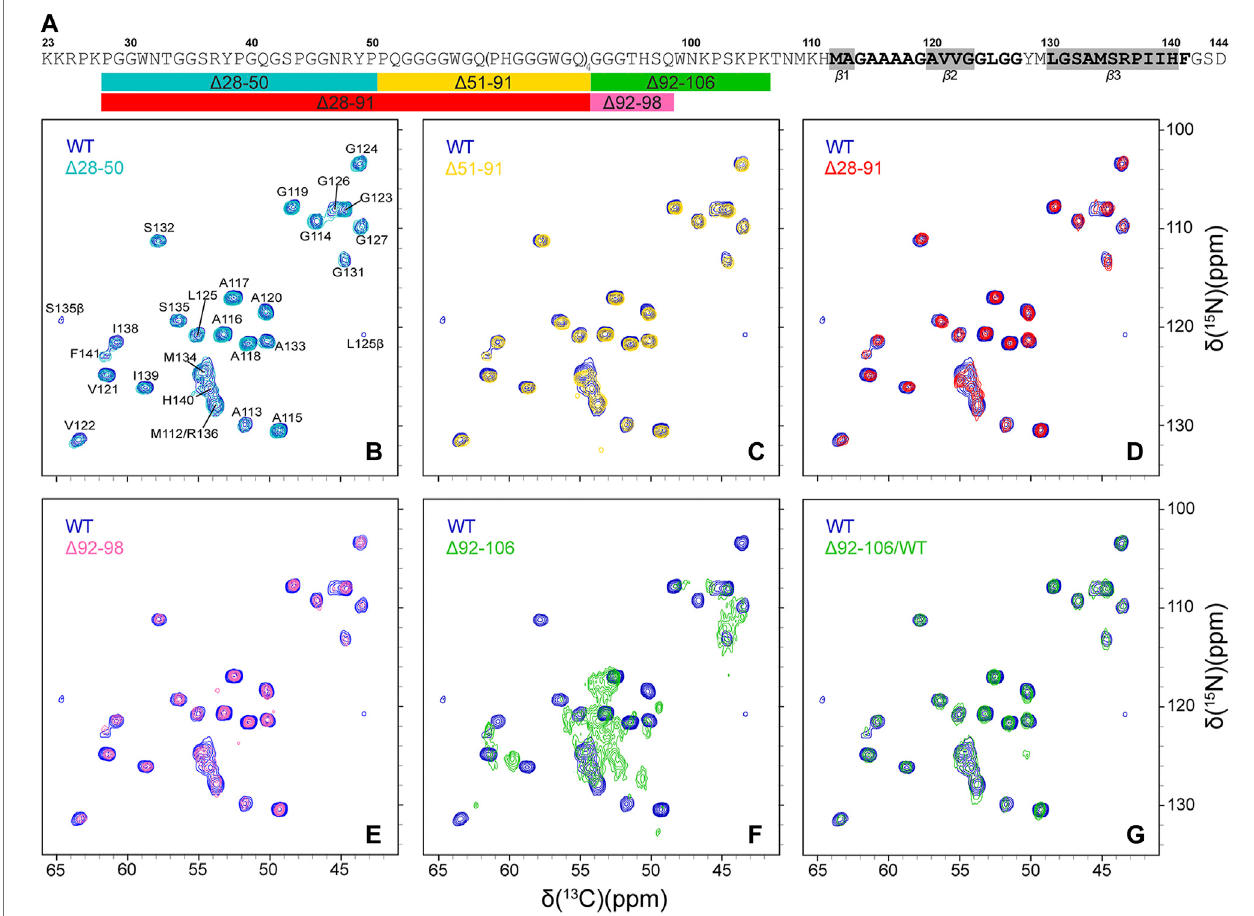
FIGURE3|(A) AminoacidsequenceofhuPrP23-144.Relativelyrigidresiduescomprisingtheamyloidcoredetectedinconventionalsolid-stateNMRexperiments are shown in bold black font, with regions having highest β -strand propensity highlighted in grey rectangles (Theint et al., 2017b), and conformationally fl exible residues (Helmusetal.,2008;Helmusetal.,2010)areshowningreyfont.TherectanglesbelowtheaminoacidsequenceschematicallyshowthekeyhuPrP23-144largedeletion variants that were investigated in this study, with the colors of the rectangles corresponding to the colors of the contours in the solid-state NMR spectra in panels (B) - (G) (B – G) 2D 15 N- 13 C α chemical shift correlation solid-state NMR spectra of Δ 28-50 (b, cyan), Δ 51-91 (c, gold), Δ 28-91 (d, red), Δ 92-98 (e, magenta), Δ 92-106 (f, green) huPrP23-144 fi brils and Δ 92-106 fi brils seeded with WT huPrP23-144 amyloid (g, green), overlaid with the reference spectrum for WT huPrP23-144 fi brils (blue).